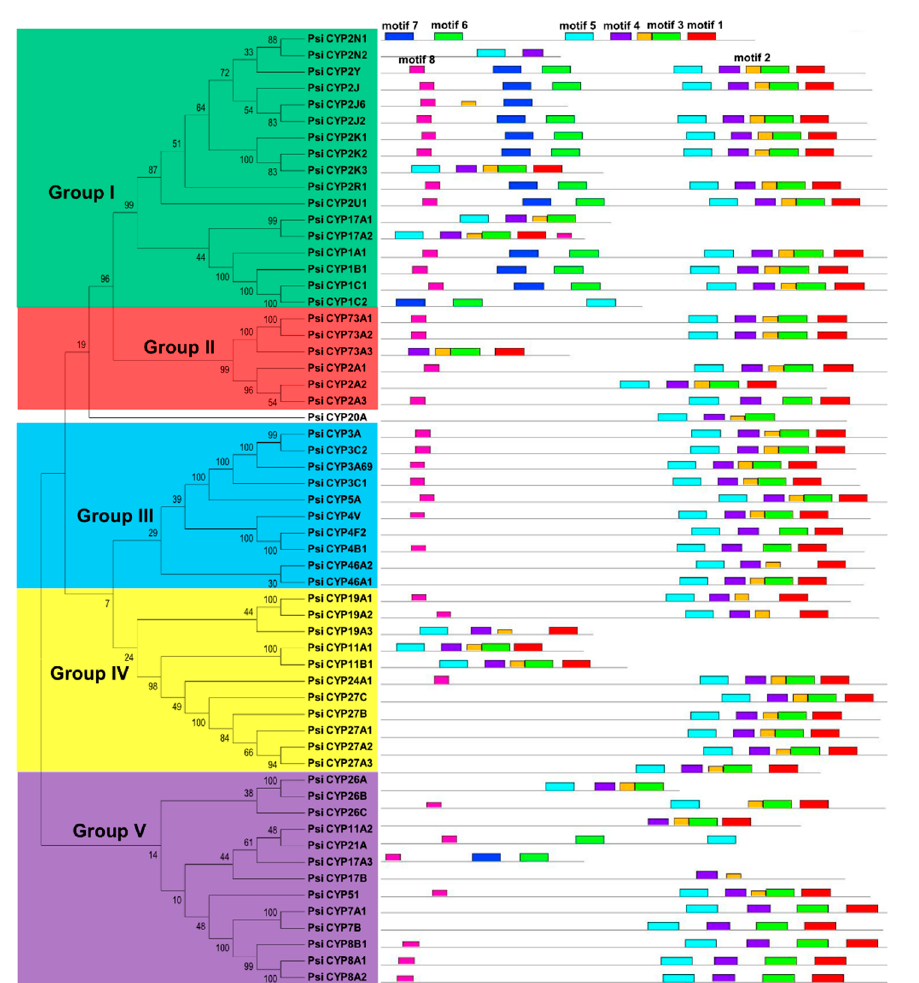
Figure 1. Phylogenetic relationships and motif compositions of the CYP genes in the P. sinensis . The phylogenetic tree was constructed and classified into five groups. Different motifs of the CYP proteins are displayed by different-colored boxes.